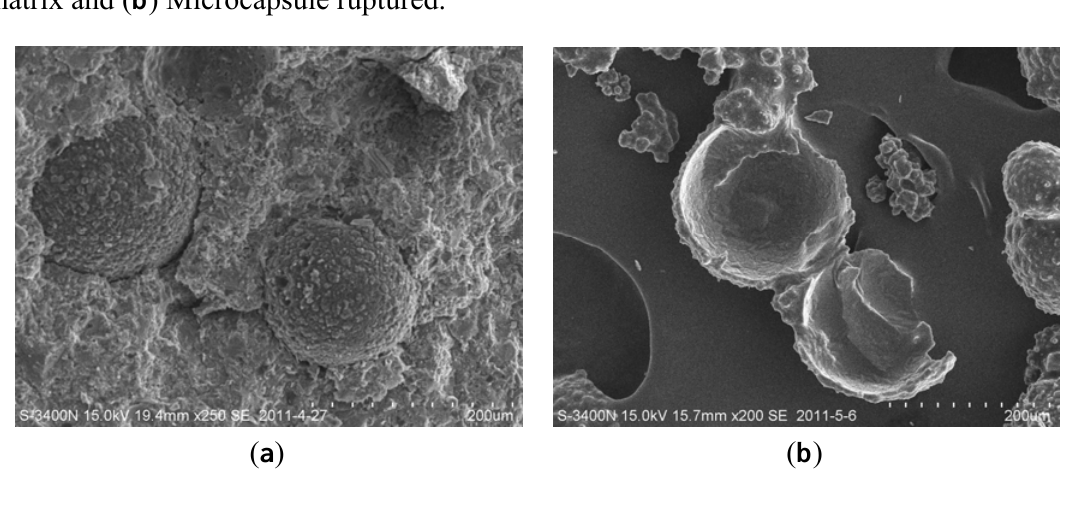
Figure 8. Fracture surface of the specimens. ( a ) Microcapsules combined with mortar matrix and ( b ) Microcapsule